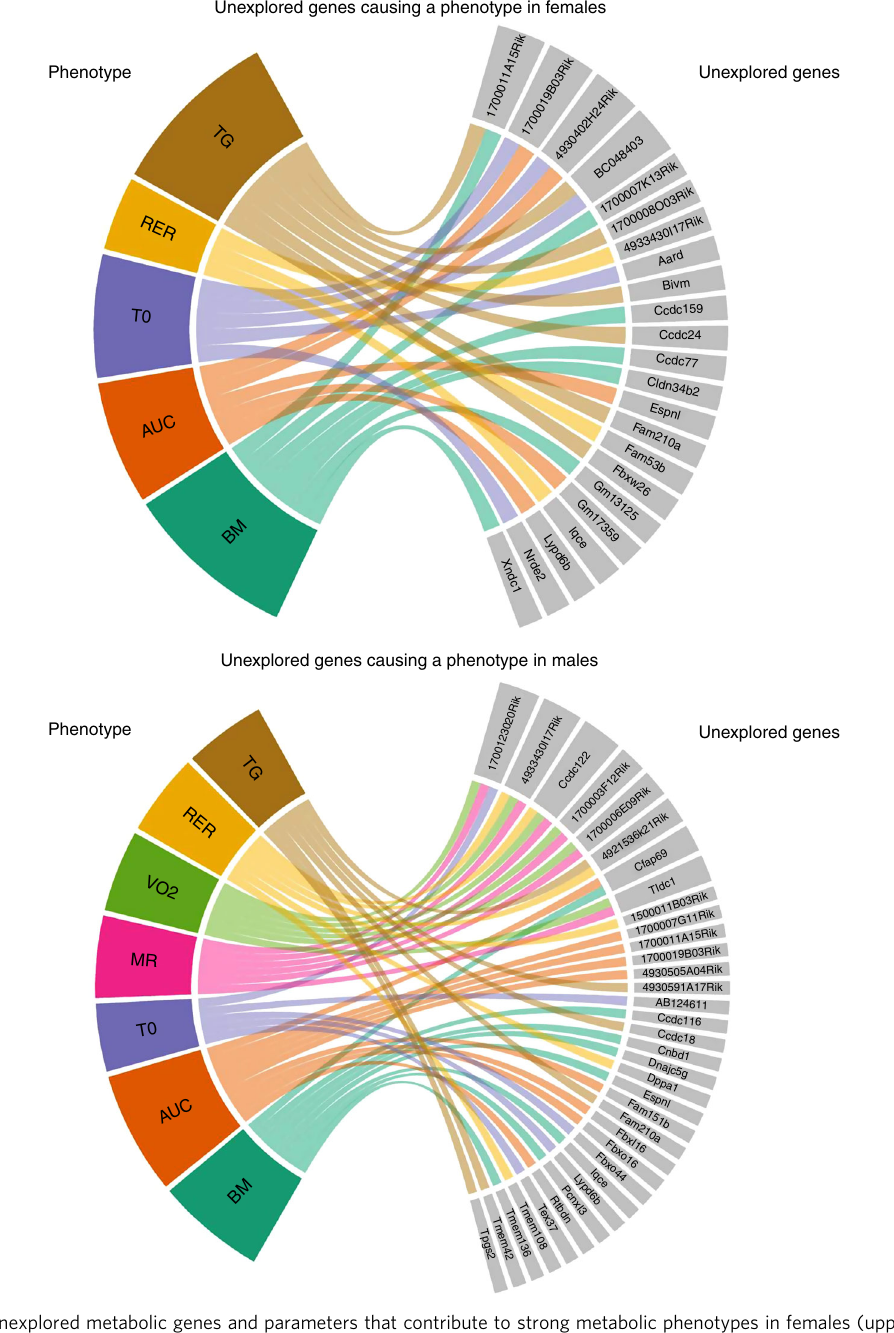
Fig. 3 Links between unexplored metabolic genes and parameters that contribute to strong metabolic phenotypes in females (upper) and males